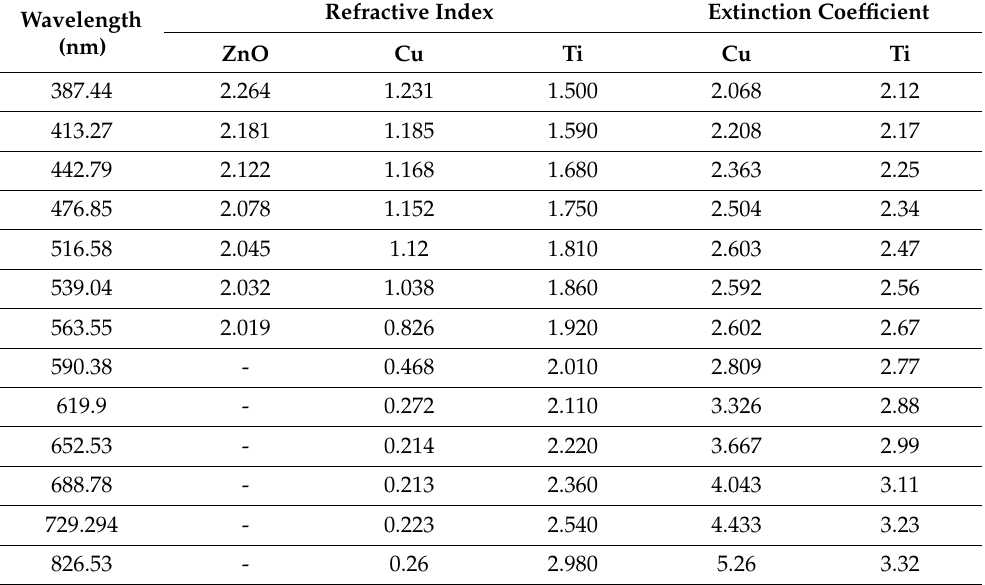
Table 1. The refractive index and extinction coefficient of ZnO, Cu and Ti at different wavelengths [24]. Wavelength